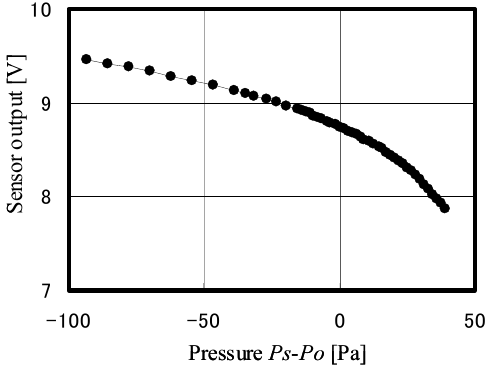
Fig. 5 Pressure calibration